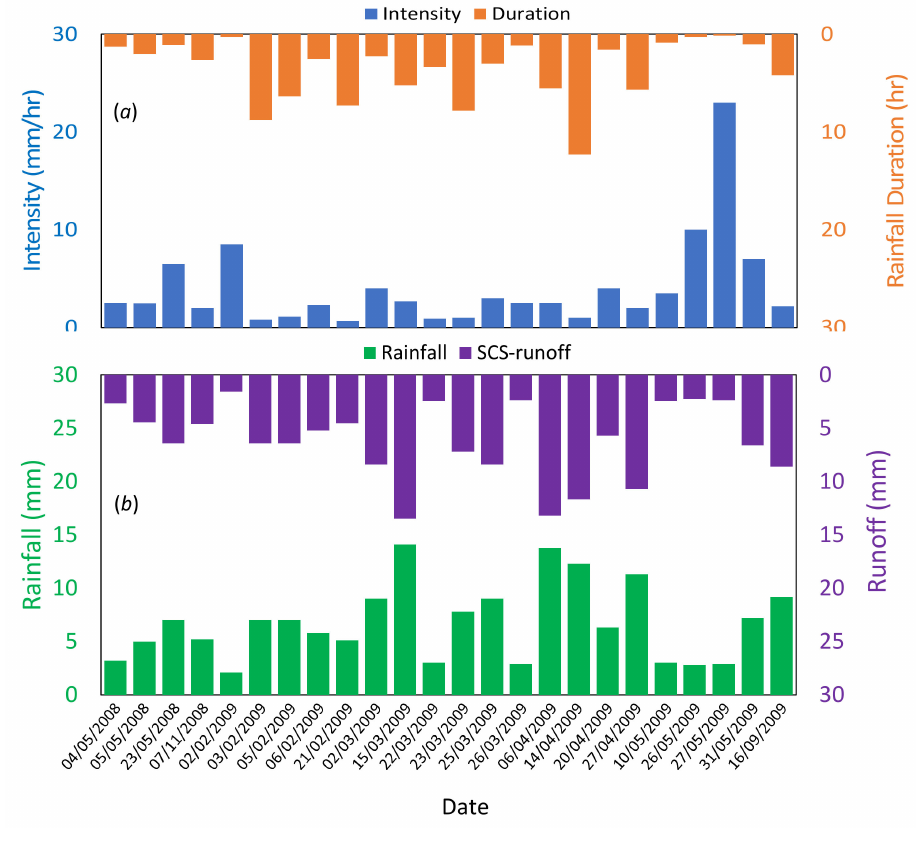
Figure 3. Intensity duration time ( a ) and depth of the rainfall events ( b ), as well as the related creation of runoff.